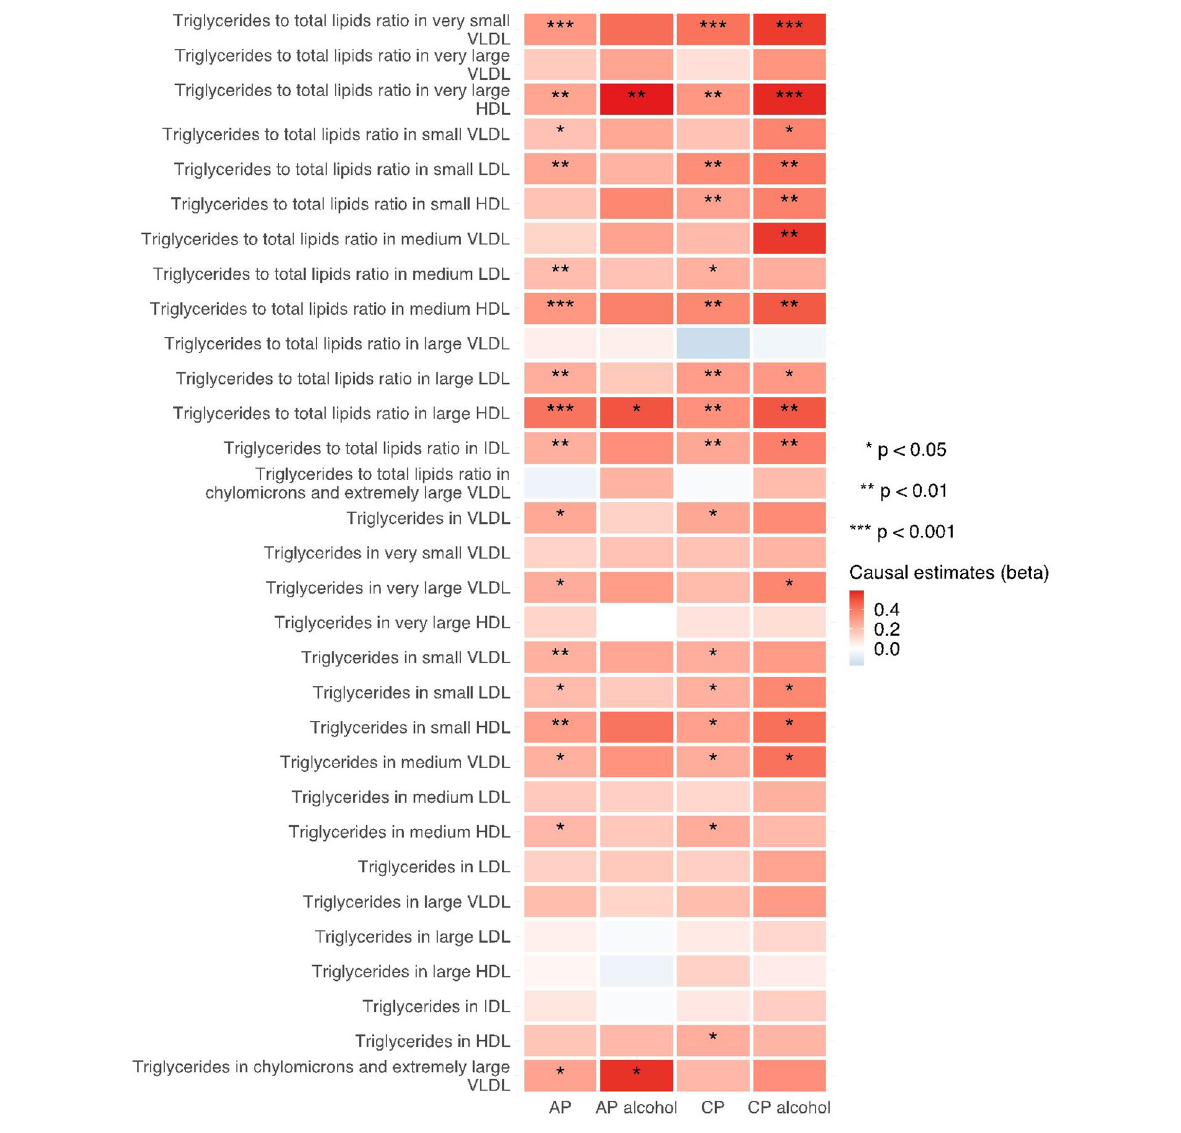
FIGURE2 Heatmap showing the IVW causal estimates of triglycerides related traits in met-d on pancreatitis using two-sample MR. AP, acute pancreatitis; CP, chronic pancreatitis; IVW, inverse-variance weighted; VLDL, very-low-density lipoprotein; LDL, low-density lipoprotein; IDL, intermediate-density lipoprotein; HDL, high-density